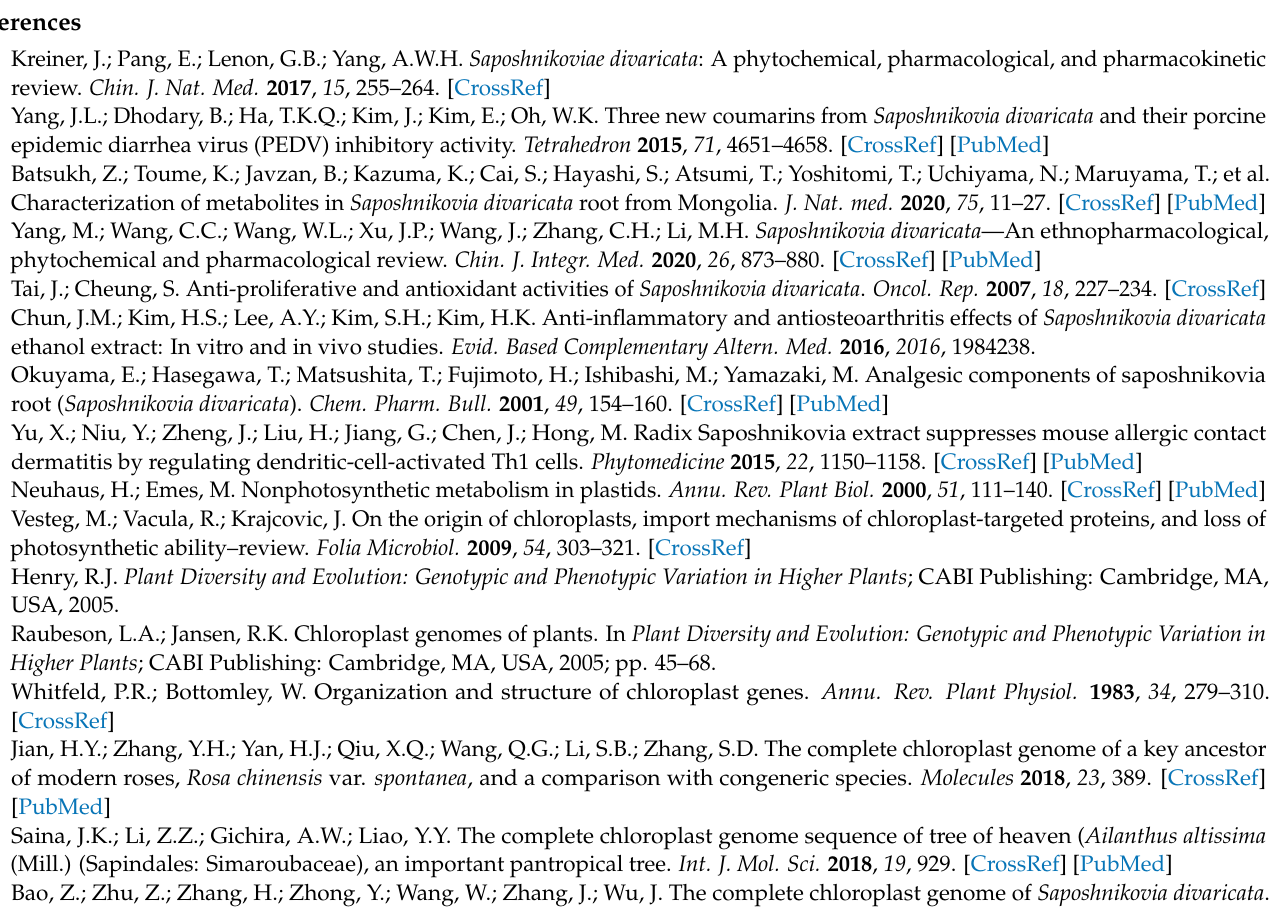
10.3390/genes13050931/s1, Table S1: Base composition in the chloroplast genome of the wild S. divaricata . Table S2: All chloroplast genome information of S. divaricata and its synonyms. Table S3: Codon-anticodon recognition patterns and codon usage for the wild S. divaricata chloroplast genome. Table S4: The information of all complete chloroplast genomes of Apioideae Drude used for phyloge- netic analysis in this